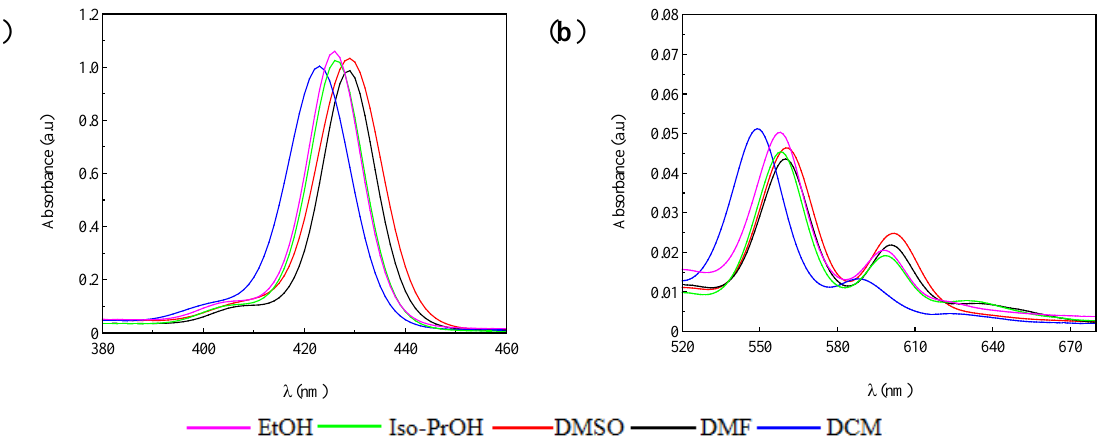
Figure 2. Absorption spectra of P1 in different solvents; ( a ) Soret bands; ( b ) Q